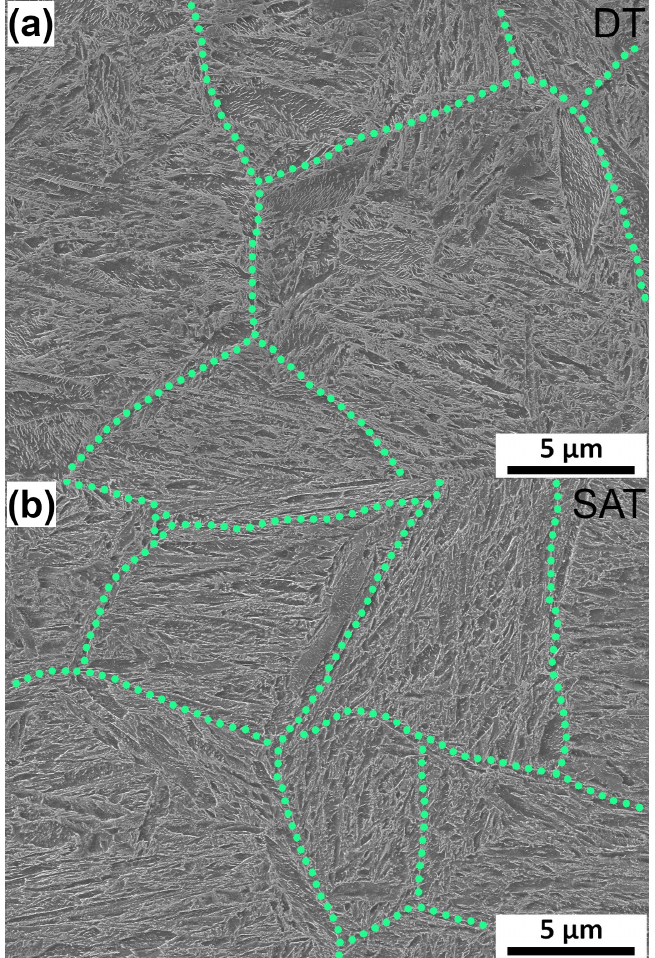
Figure 4. SEM micrographs (secondary electron mode) showing microstructures of ( a ) DT (quenched and double-tempered sample at 523 K (250 °C) and 673 K (400 °C)) and ( b ) SAT (quenched, tempered at 523 K (250 °C), rotary swaged, and tempered at 673 K (400 °C)) samples. Green dot lines indicate primary austenite grain boundaries. The crystallographic orientations of the grains in the DT and SAT samples are shown